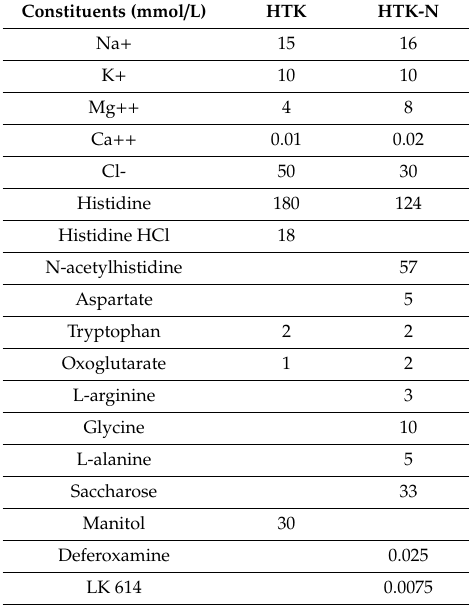
Table 2. Composition of HTK and